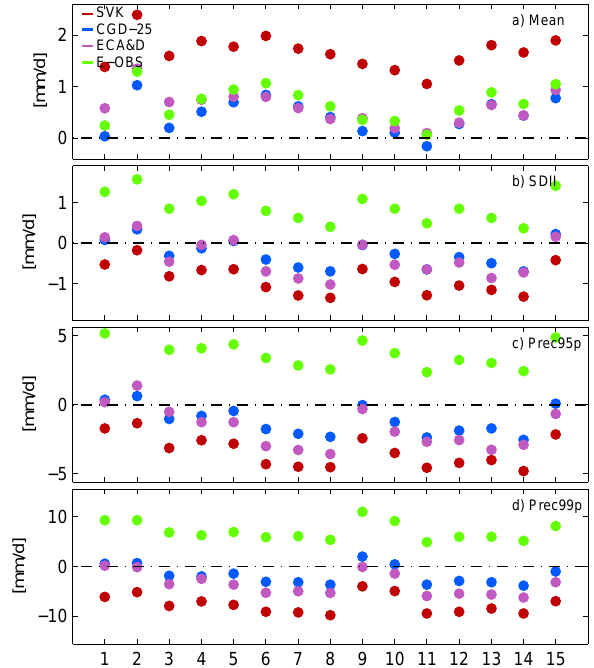
Fig. 5. Bias of each of the RCMs in the ensemble estimated using the four observational data sets. Model numbers are shown in Ta- ble